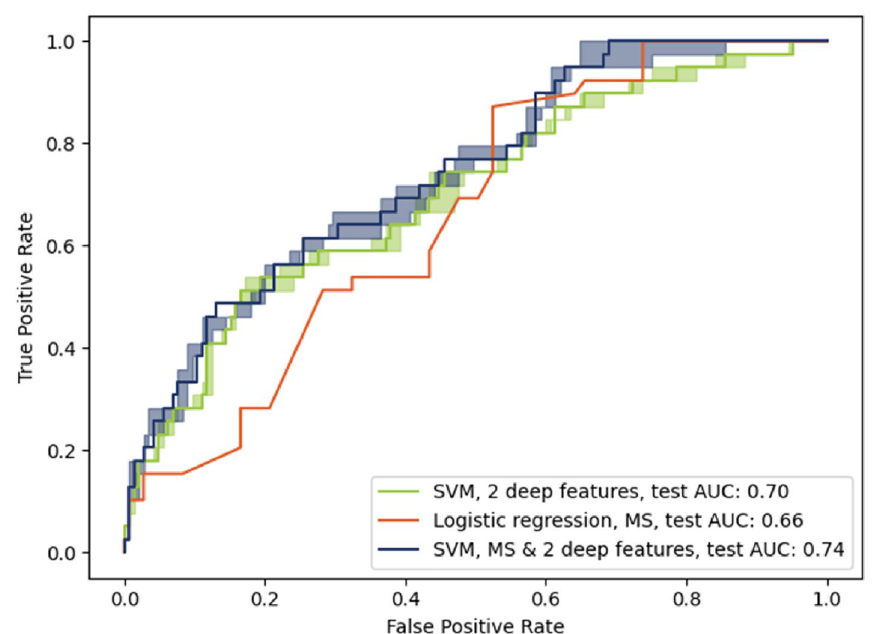
Figure 5. Testing performances of the developed models. The model using the deep imaging features performed worse on the testing set than on the validation set (0.70 compared to 0.88), pointing to some overfitting. In contrast, the mortality score model similarly (0.66 compared to 0.62). Combining the imaging features with the mortality score yielded a slightly higher AUC of 0.74, using the same SVM classifier. There are 145 positive samples (survival) and 39 negative samples (Deaths) in the testing